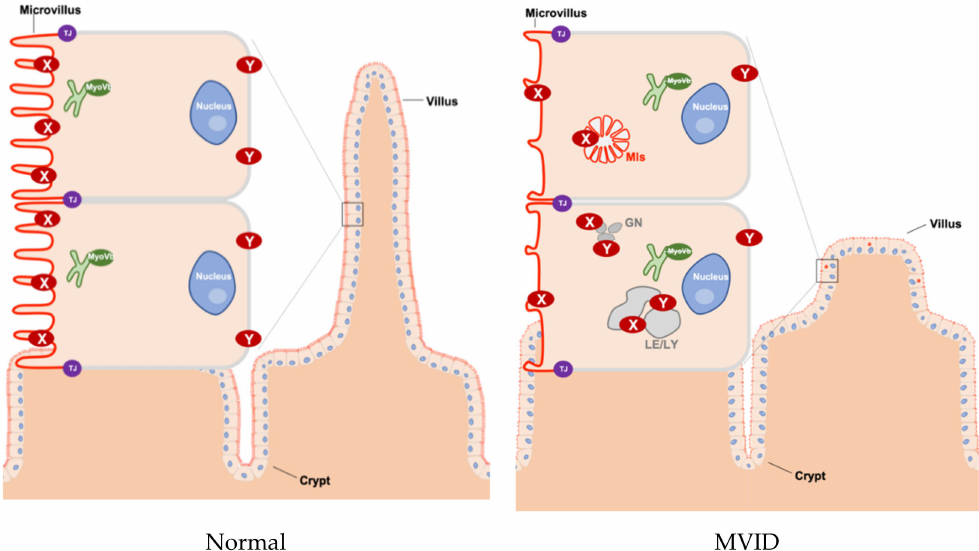
Figure 1. Schematic overview of tissue and cellular characteristics of healthy and MVID intestinal epithelium. In healthy enterocytes, the recycling endosome (green) is located sub-apically and plays an important role in transporting proteins to the plasma membrane (in particular to the apical membrane). However, in MVID that is caused by the loss function of myosin Vb (MyoVb), the villi show hypoplasia and microvilli are atrophic. Moreover, the proteins (marked as X and Y) in the plasma membrane are mislocalized in microvillus inclusions (MIs) or in enlarged late endo/lysosomes (LE/LY) and granules (GN). X indicates CD10, DRA, GLUT5, NHE3, SGLT1, sucrase-isomaltase (SI), 5’-nucleotidase (5 (cid:48) NT), alkaline phosphatase (AP), AQP7, CD36, CFTR, DPPIV. Y indicates transferrin receptor (Tfr), Na + /K + ATPase. TJ: tight junction, MIs: microvillus inclusions, LE: late endosomes, LY: lysosomes, GN: